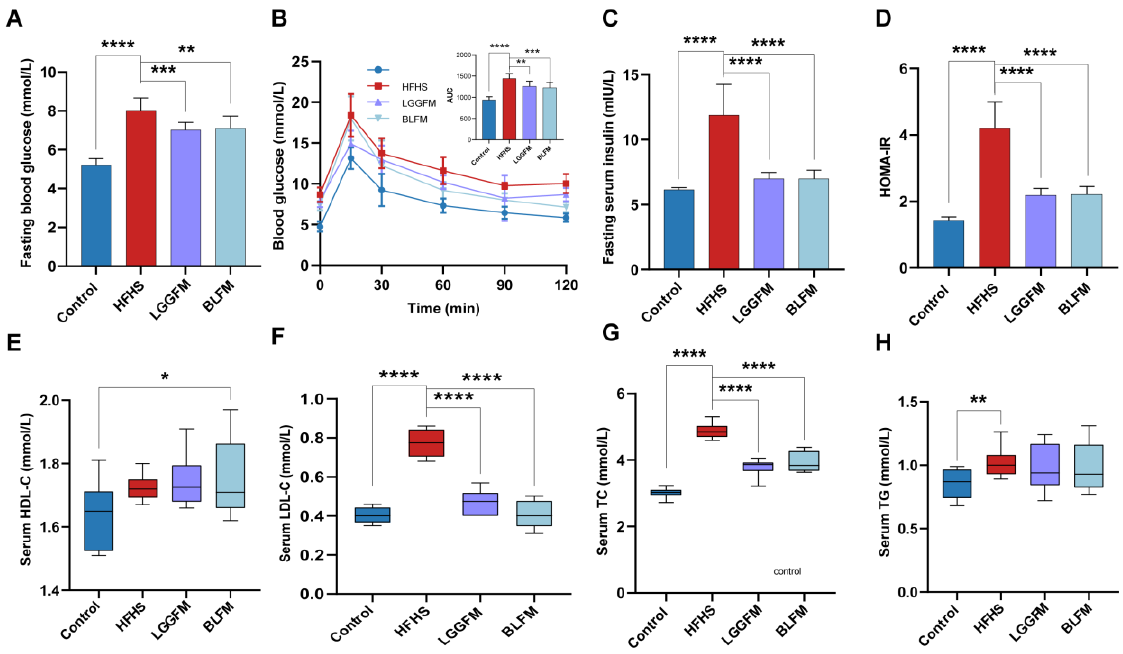
Figure 2. Supplementing fermented milk improves glucose and lipid metabolism disorders in mice: